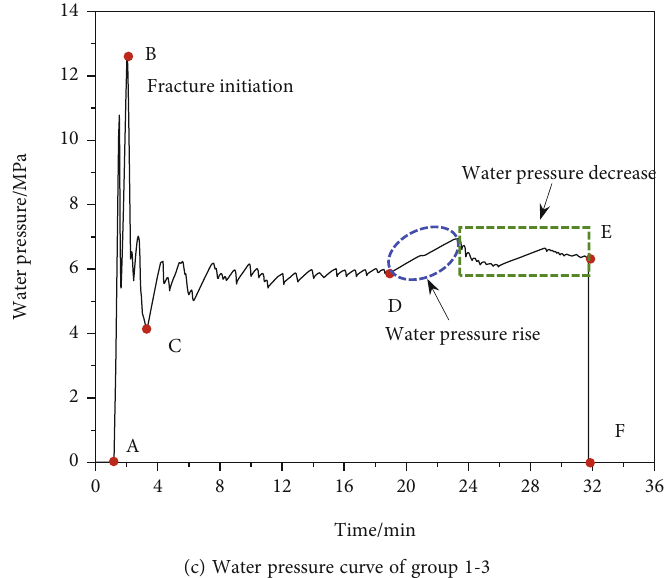
Figure 16: Water pressure curve of composite layered rock under di ff erent injection